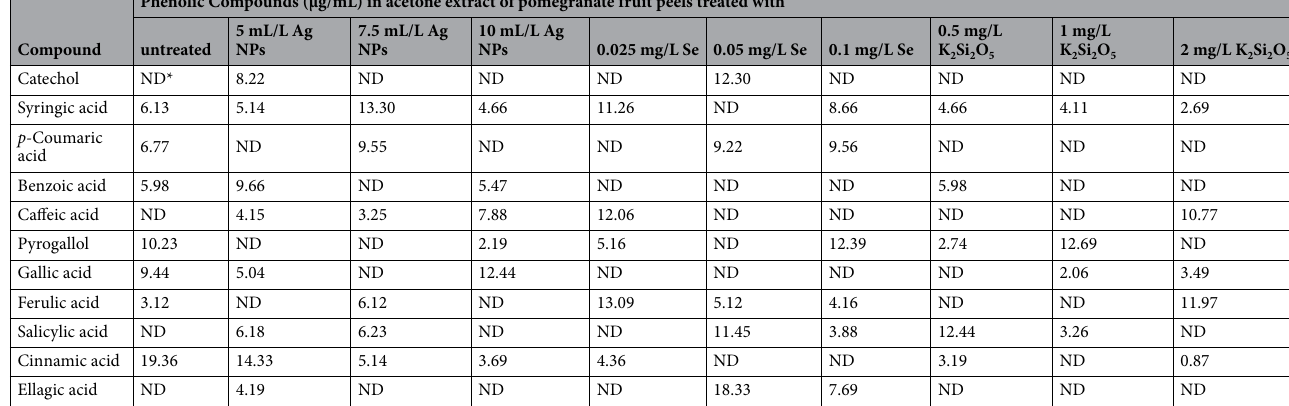
Table 11. HPLC analysis of phenolic compounds in acetone extract of pomegranate fruit peels treated with different treatments. * ND not